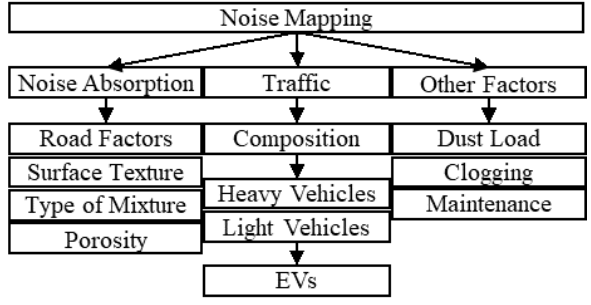
Figure 1: Noise mapping-related variables